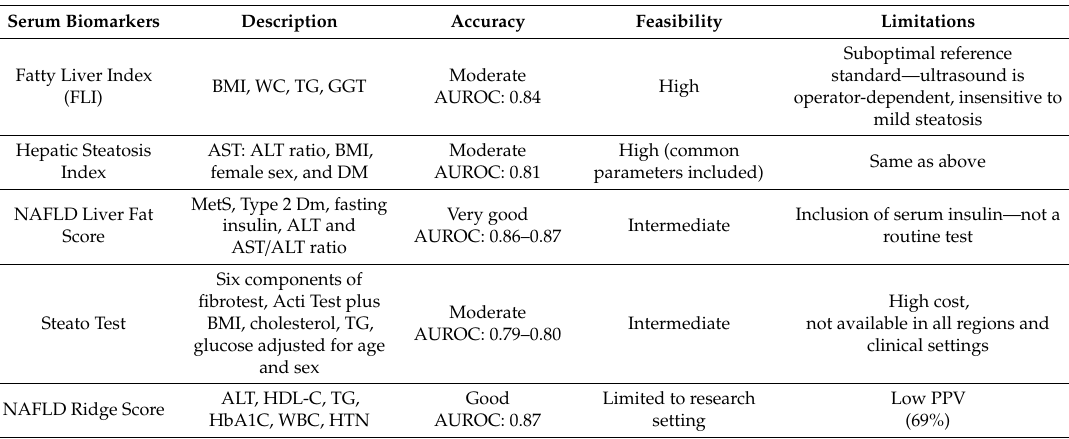
Table 1. Serum biomarkers for hepatic